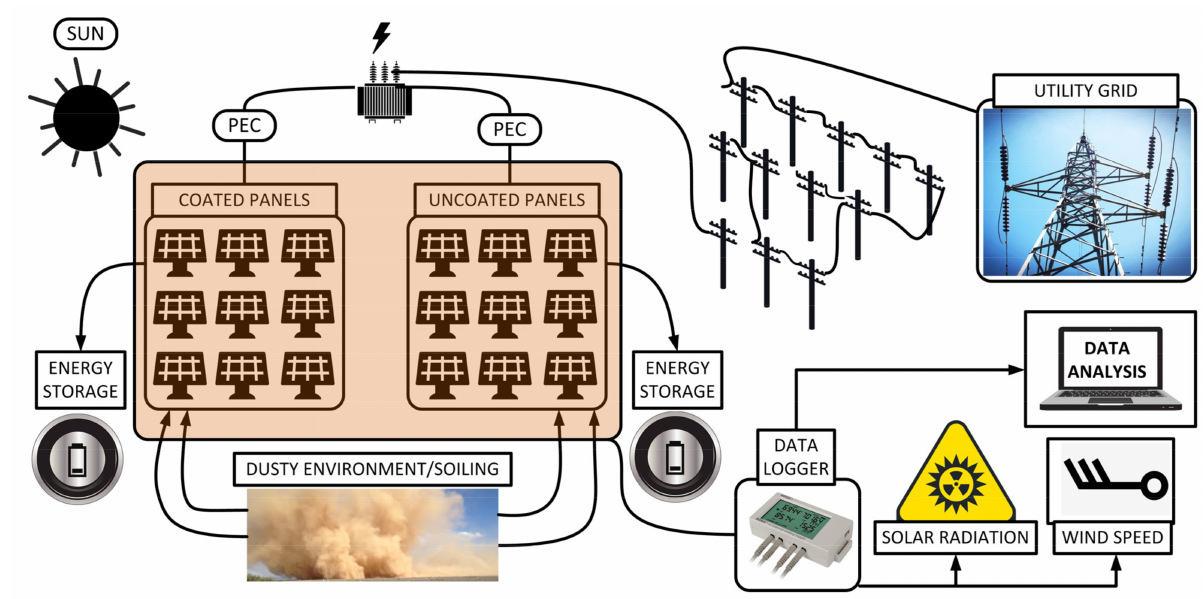
Figure 2. Performance monitoring and analysis of PV performance with cleaning